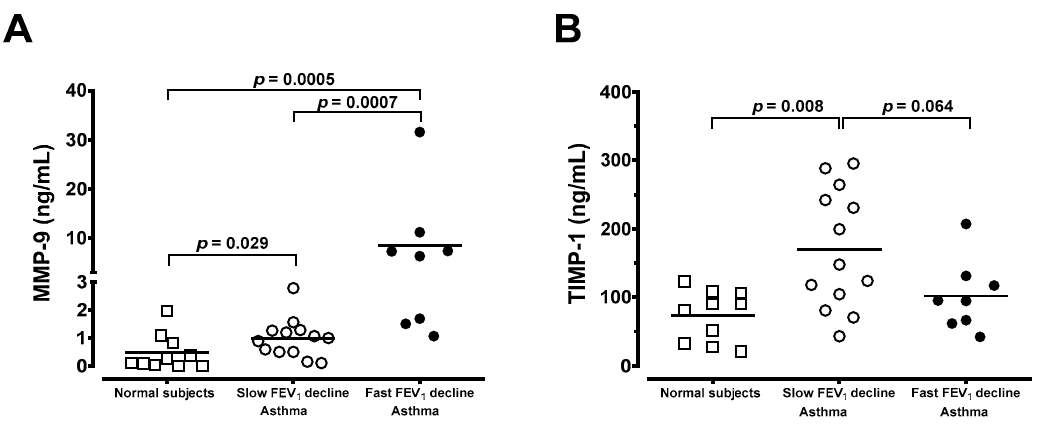
Figure 5. Individual concentration of ( A ) MMP-9 and ( B ) TIMP-1 spontaneously released from alveolar macrophages after 24 h culture in normal subjects (open square, n = 10), chronic asthma with a slow FEV 1 decline (open circle, n = 13), and chronic asthma with a fast FEV 1 decline in (solid circle, n = 8). The significance is